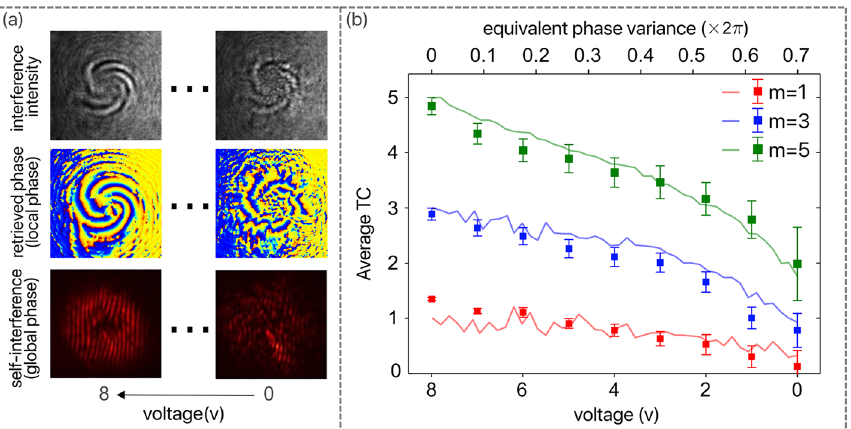
Figure 4. Experimental results. Panel ( a ): an example of measured intensity and phase of the scattered field 5 corresponding to the highest (voltage 0) and the lowest (voltage 8) scattering perturbation. All for case m = measurements are for the same propagation distance and the only adjustable parameter is the voltage applied to the heater. Panel ( b ): comparison between the experimental results (solid symbols, bottom axis) and the numerical calculation (solid lines, top axis) conducted for the specific scattering conditions. The experimental results were averaged over four measurements at different locations across the TPS while the numerical data was averaged over 30 realizations of the randomness. For both simulation and experiment, the vorticity was calculated over square contours around the optical axis. The equivalent extent of the phase variance was found based on the measured statistical properties of the